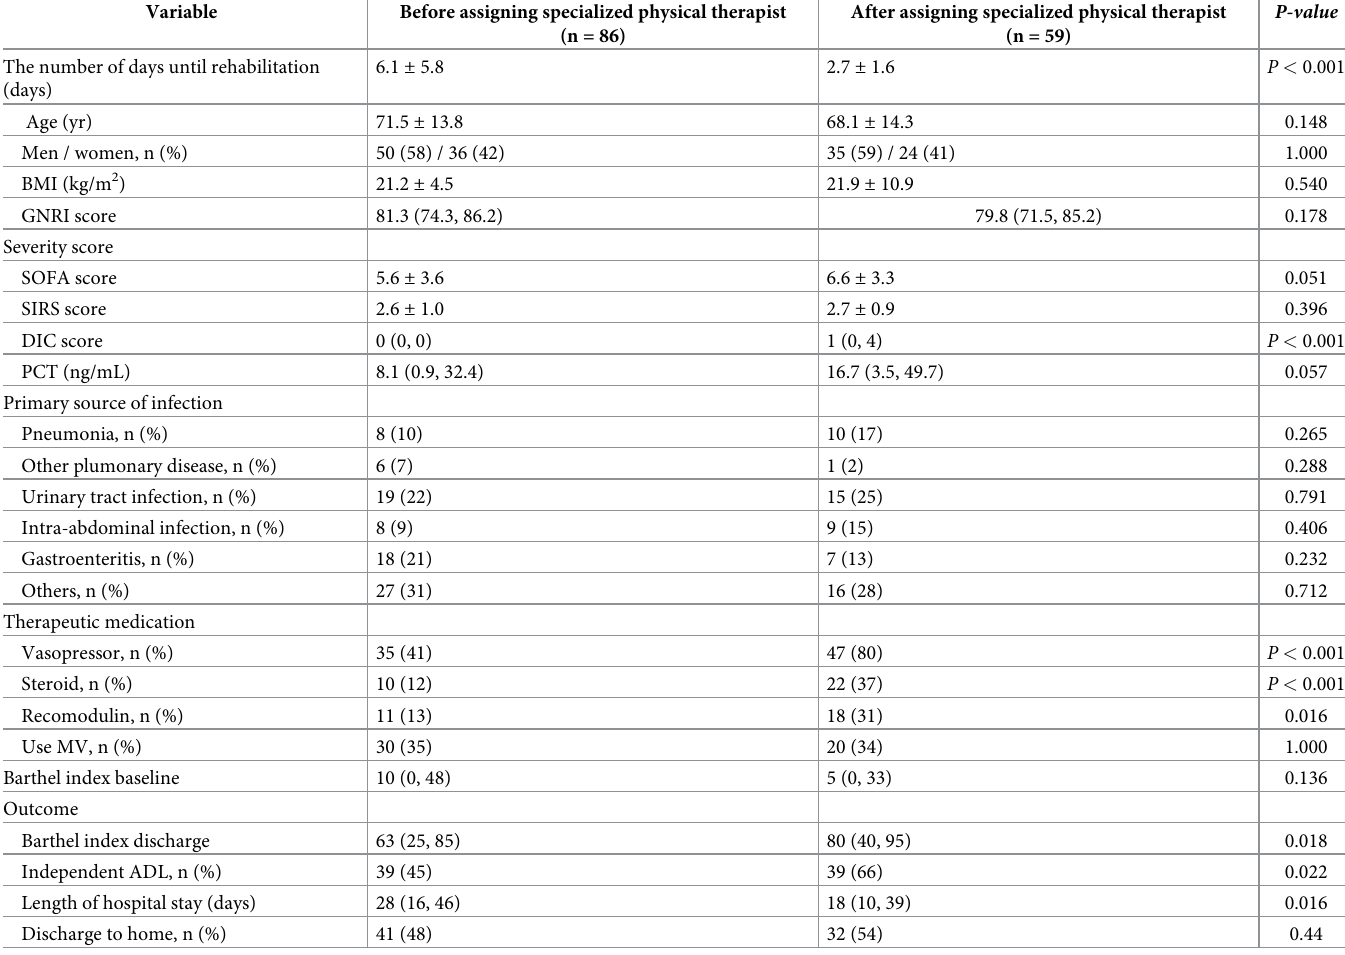
Table 1. Demographic clinical characteristics in AECCC and hospital